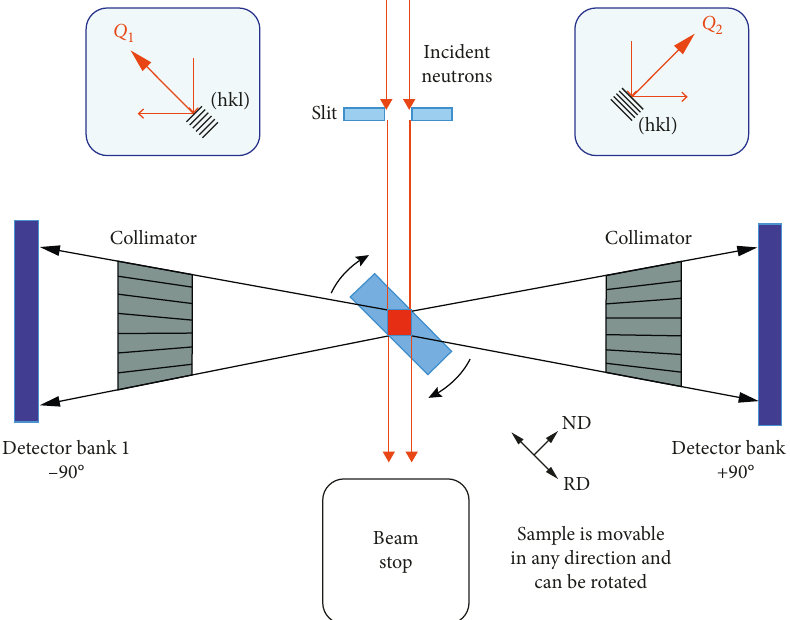
Figure 2: Top view of the ORNL TOF-ND VULCAN diffractometer and sample placement (not to scale). The simultaneous collection of diffraction spectra from two detector banks allows determinations of element and phase percentages using Rietveld refinement. The X , Y , Z movable and rotatable sample holder provides multiple angles in the XY plane for partial texture analyses and a computer-controlled sequential analysis of the coins (the coins are stacked vertically in the Z